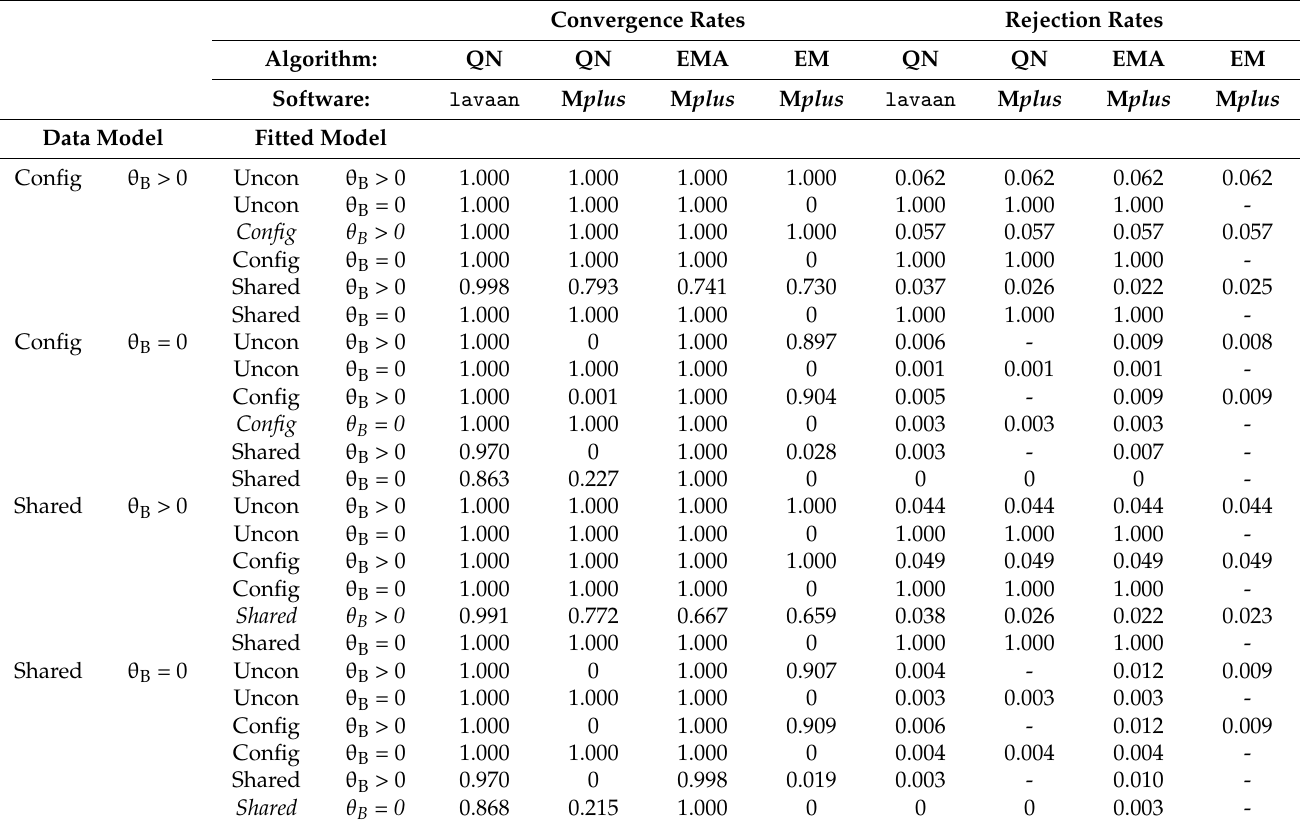
Table 5. Convergence and rejection rates with 100 clusters across ML estimation algorithms. Convergence